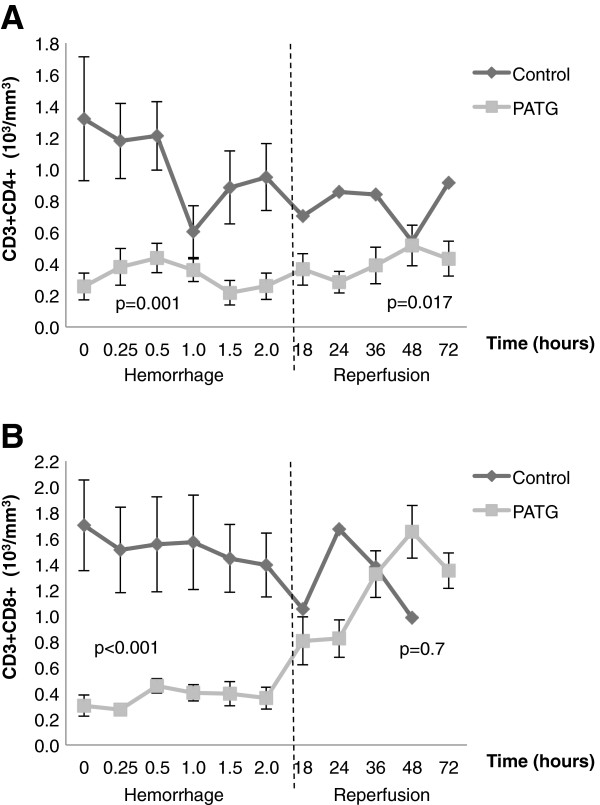
CD3+CD4+ and CD3+CD8+ lymphocyte counts were quantified throughout hemorrhage and reperfusion A) Quantification of CD3+CD4+ and B) CD3+CD8+ lymphocytes throughout the experiment. One-way ANOVA with repeated measures design was used for statistical comparison. Error bars represent ± SEM.